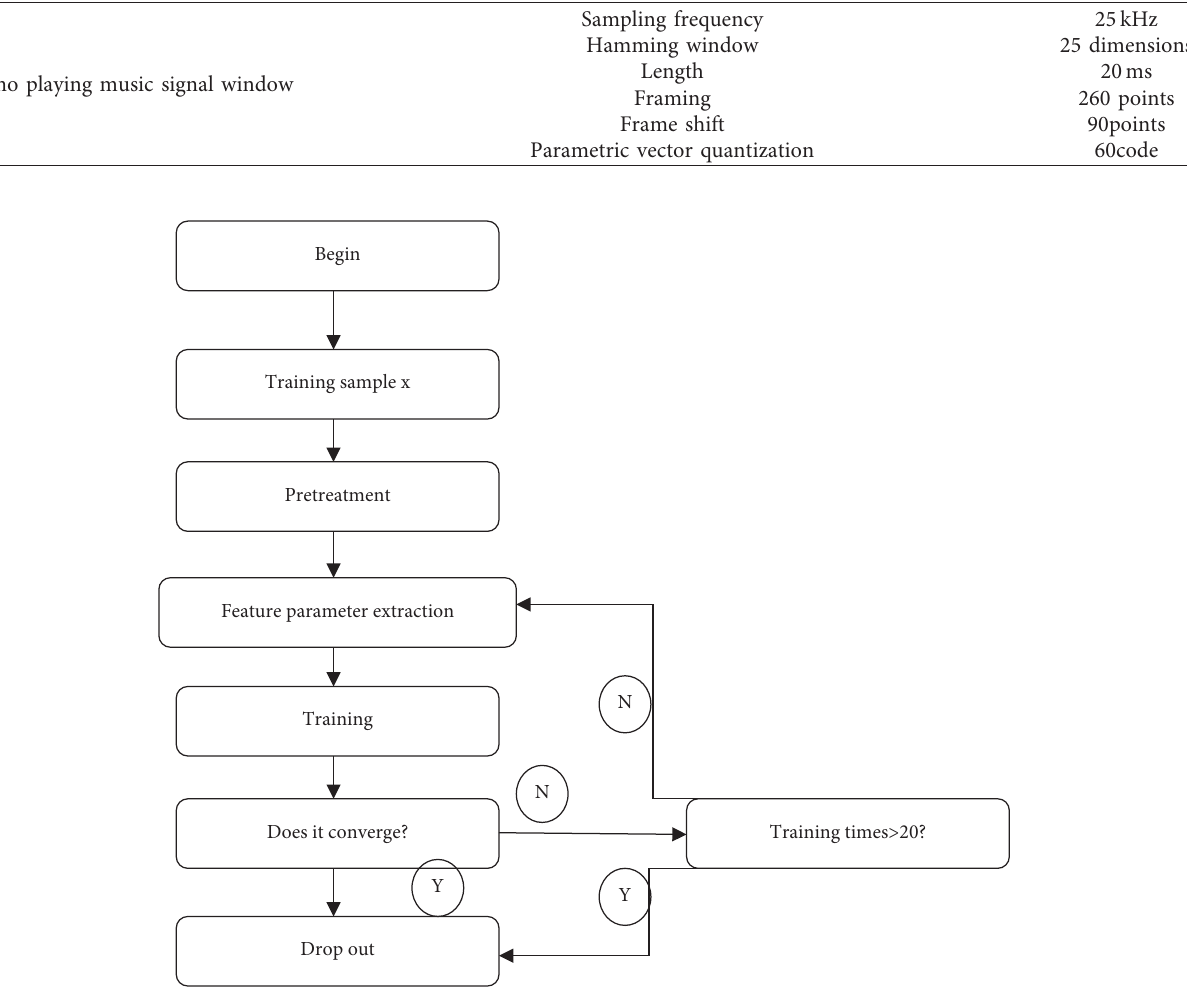
Figure 8: The training and recognition process of the speech recognition system based on the hidden Markov